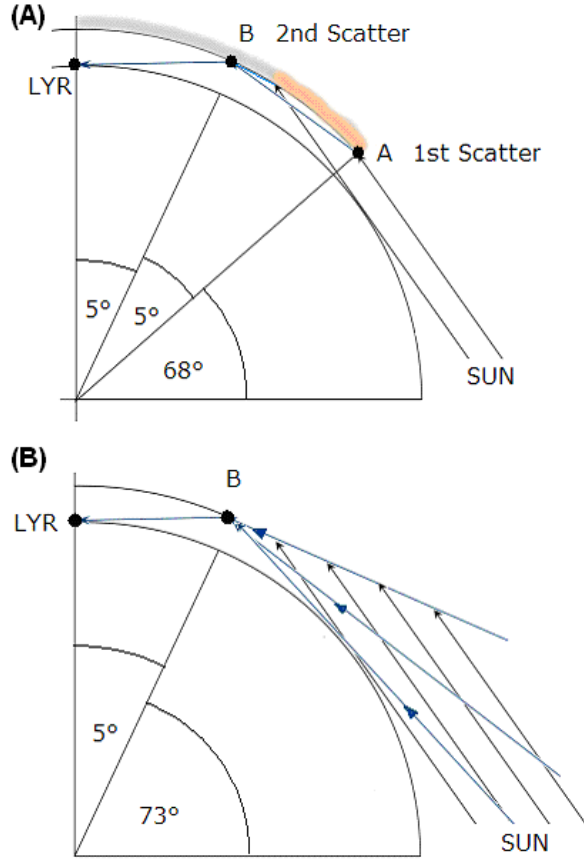
Fig. 10. Two scenarios for the red-sky enigma: (A) PSC Cloud-to- Cloud scattering mechanism and (B) PSC twilight illumination. Figure 10. Two scenarios for the red-sky enigma: (A) PSC Cloud-to-Cloud scattering mechanism and (B) PSC twilight illumination.